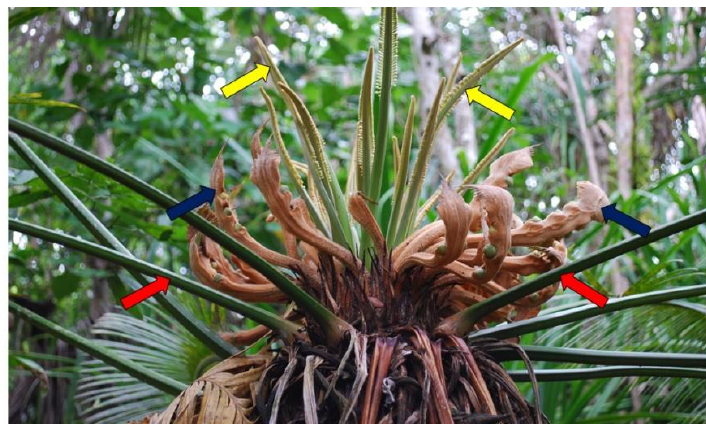
Figure 4. The reproductive behavior of a female Cycas plant produces a megastrobilus that is not determinate. Each sporophyll is an obvious homolog of the pinnate compound leaf. Sporophylls from a megastrobilus (blue arrows) separate the antecedent (red arrows) and subsequent (yellow arrows) leaf growth events.